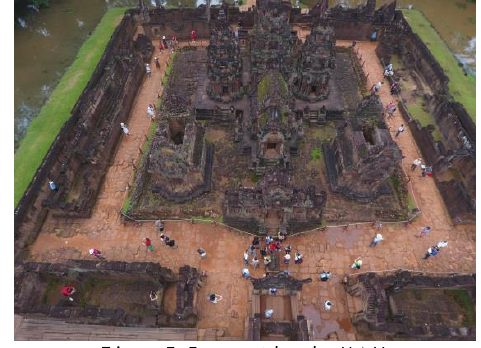
Figure 5. Images taken by